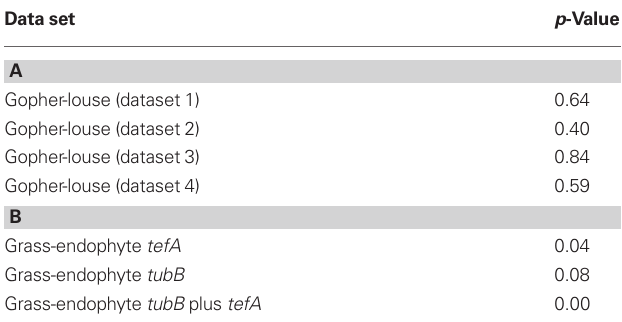
Table 2 | (a) p - Values for subsets of the well-known gopher-louse data set in Hafner and Nadler (1990) . All p-values are high, so no significant incongruence is found. (B) p -Values for grass-endophyte data sets from Schardl et al. (2008). After removing cases of apparent host jumps, the data comprises 20 taxa of grasses and 20 taxa of endophytes. The first two rows compare grass phylogeny to gene trees for tefA and tubB in endophytes; the last row uses the concatenation of tefA and tubB .